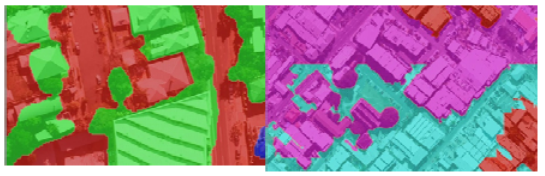
Figure 6. Mosaic with overlaid cut-line (each color is a